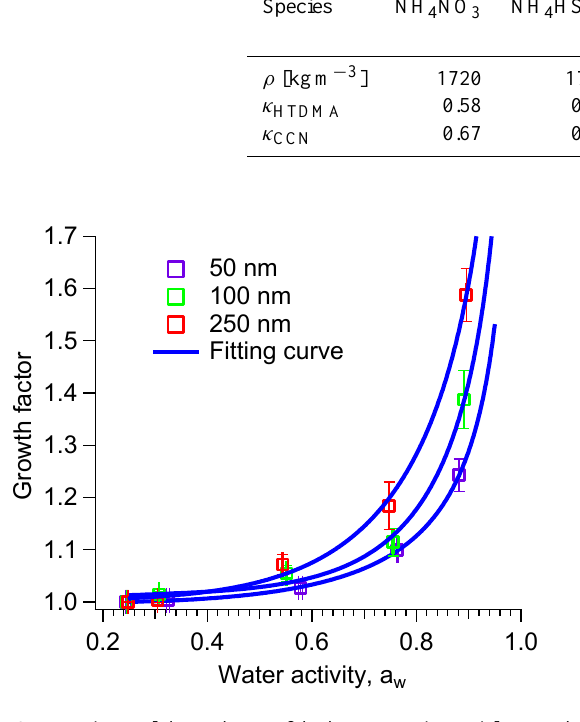
Fig. 2: Experimental dependence of the hygroscopic particle growth factor (HGF) on the water 764 Fig. 2. Experimental dependence of the hygroscopic particle growth activity. The data represent the total average of HCCT-2010. 765 factor (HGF) on the water activity. The data represent the total av- erage of HCCT-2010.